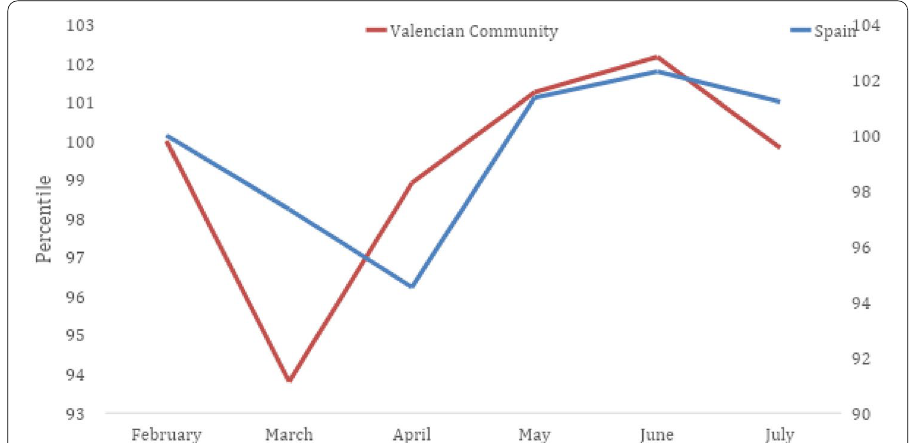
Fig. 4 Evolution of the affiliation of workers in the Spanish textile-clothing industry. Source: Own